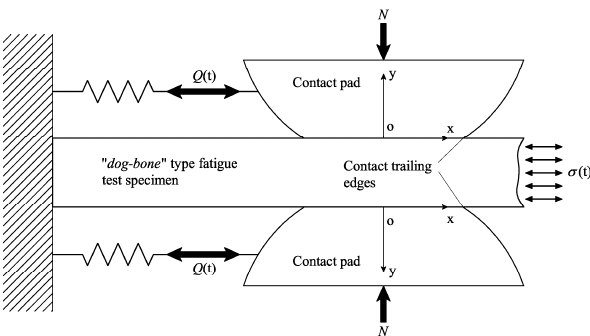
Figure 1: Scheme of the experimental